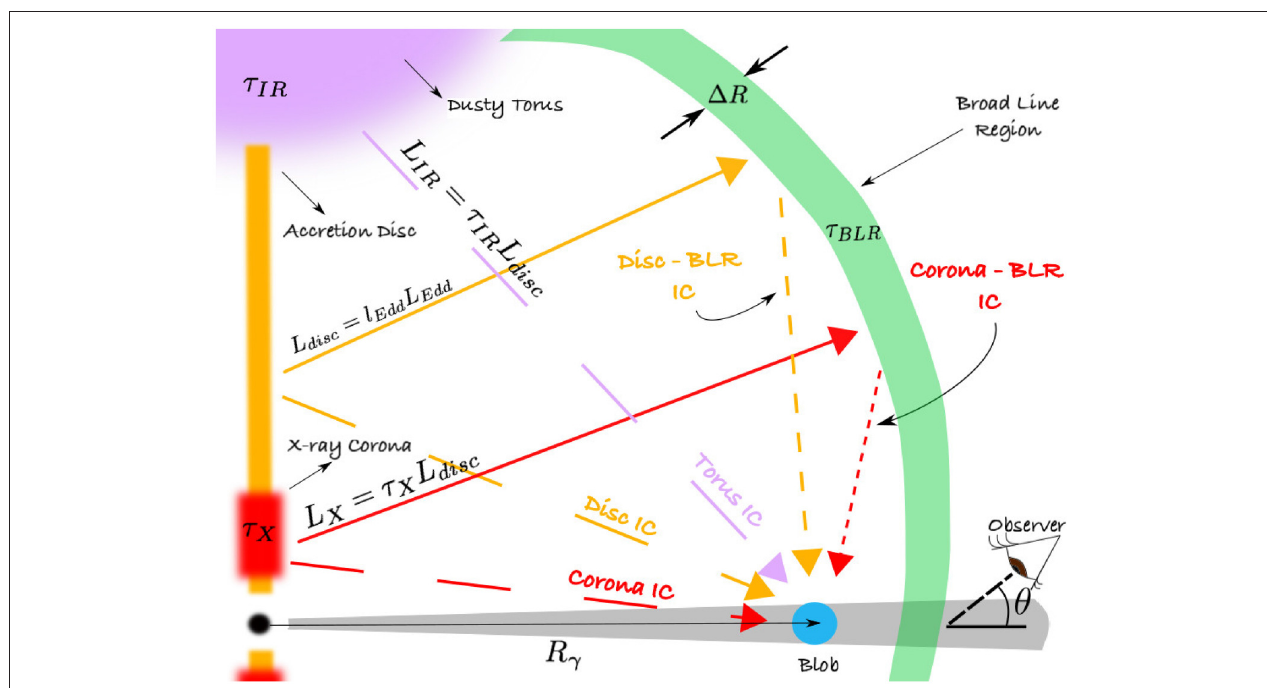
FIGURE 1 | Sketch showing the different external photon fields featured in our multi-component model. The direct radiation from the components are scaled by the black hole accretion rate, and they are also dependent on the characteristics of corresponding photon field, under the form of the scaling factors τ IR for the dusty torus and τ X for the X-ray corona. As for the IC components, they also depend on the opacities of the different photon fields, τ X , BLR and τ BLR for the accretion disc photons IC scattered in the BLR and for the X-ray corona photons IC scattered in the BLR respectively. Note that for our model we consider a BLR of width 1 R = R in BLR − R out BLR